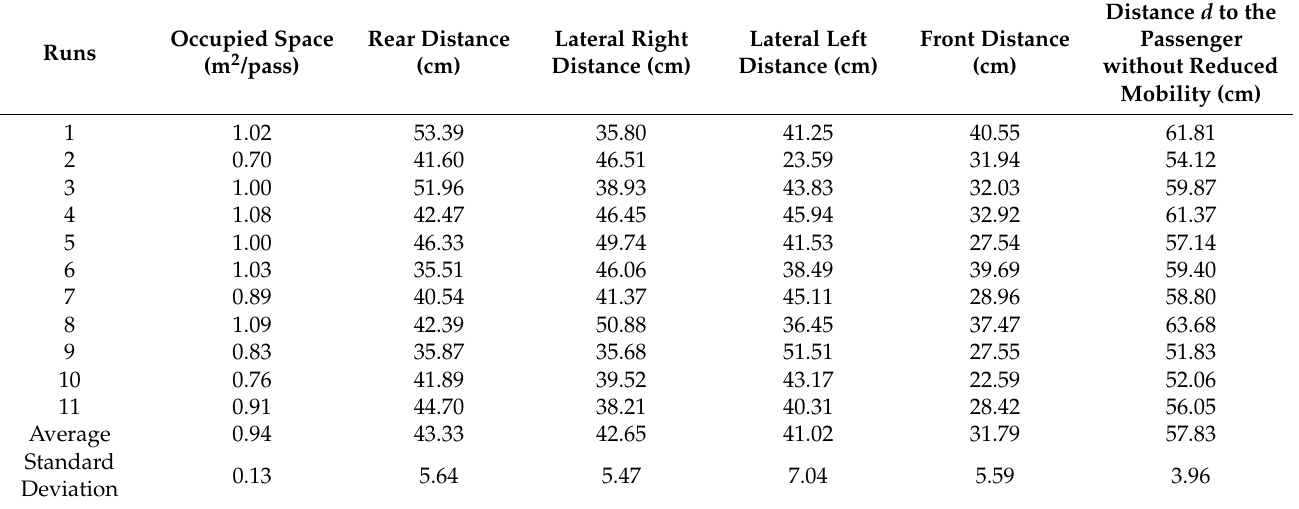
Table 4. Average space occupied by passengers without reduced mobility waiting to board the